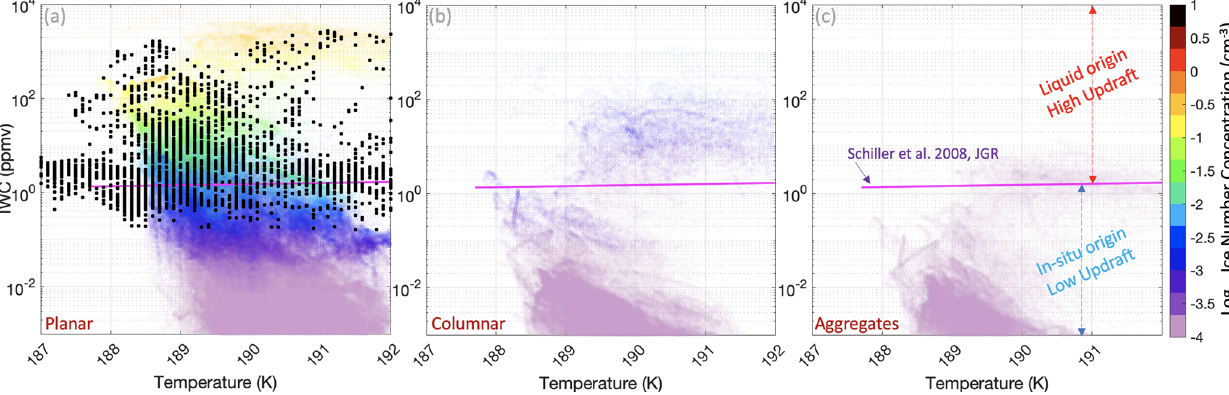
Figure 9. Simulated (shaded) and observed (black dots) IWC versus temperature color coded by the log 10 of ice number concentration at 17km and D ice > 3µm using the ISHMAEL scheme from three ice habits: (a) planar, (b) columnar, and (c)